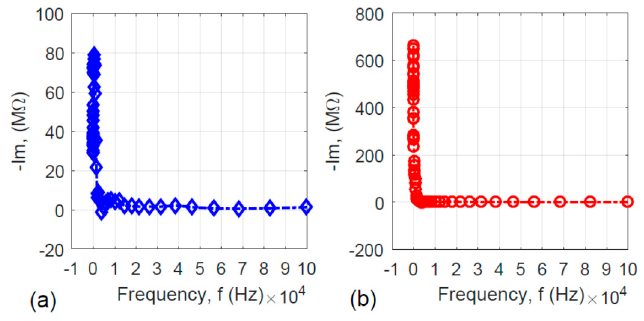
Figure 7. Frequency responses of the imaginary part (Im) of the specimens’ impedance: ( a ) without hydrothermal carbonization treatment and ( b ) with hydrothermal carbonization treatment.